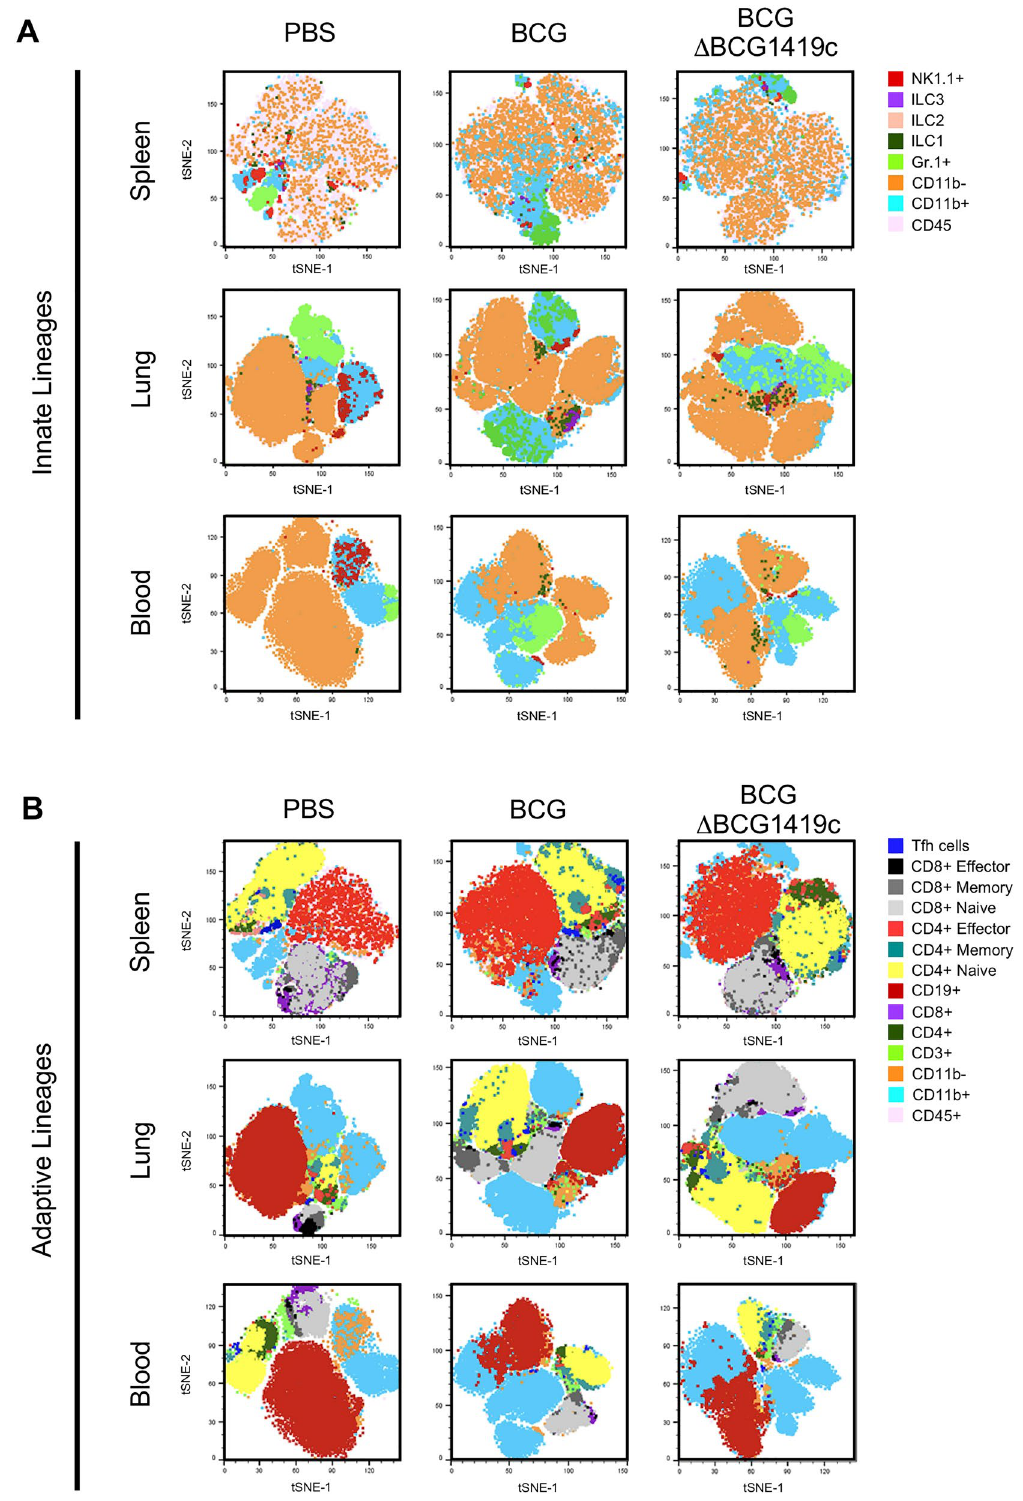
Figure 2. Graph-based clustering of PBS-, BCG- and BCGΔBCG1419c-induced immune populations visualized by T-distributed Stochastic Neighbor Embedding (tSNE). Representative tSNE maps of CD45 + cells in the ( A ) blood, ( B ) spleen and ( C ) lungs of control, BCG- and BCGΔBCG1419c-immunized mice. In each t-SNE plot, clusters are color coded and assigned a lineage identification based on the markers for which are defined in Fig.